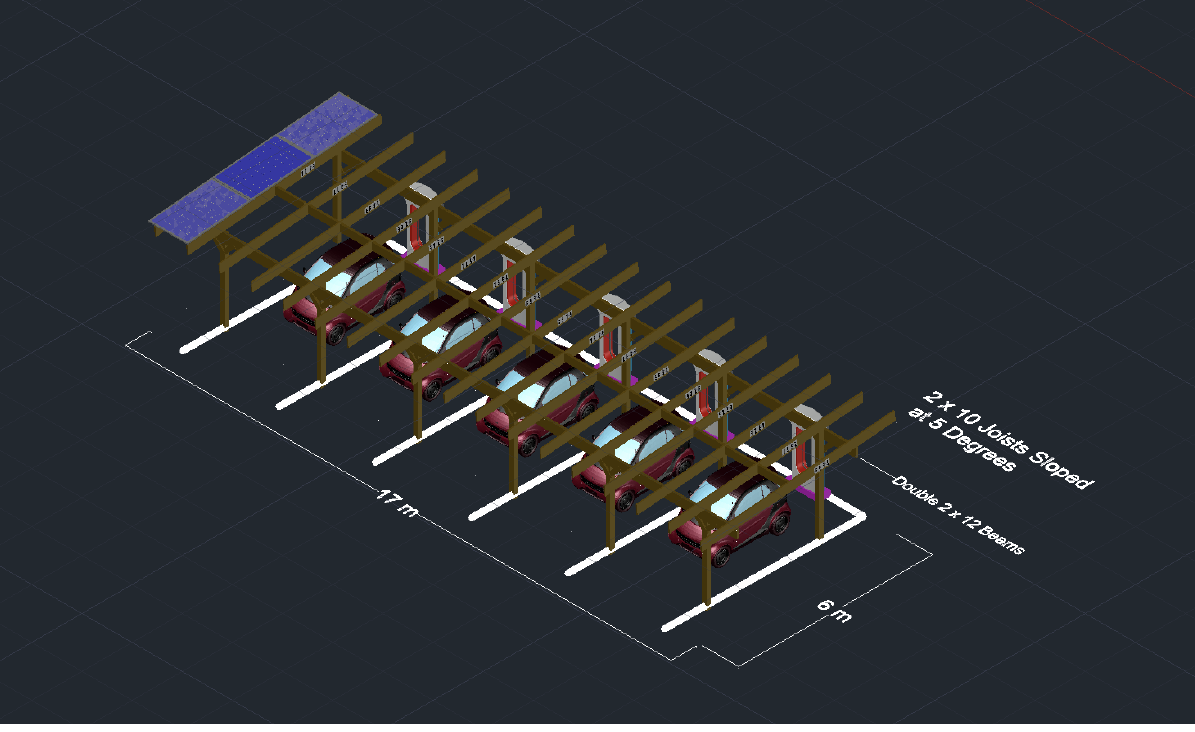
Figure 6. Finished Single-Span System. 3.2. Double Spanning System 3.2.1. Double Spanning System Bill of Materials The BOM of the two-span system is shown in Table 5 in Canadian dollars sourced from Copp’s Build-All, London, and Metal Supermarkets, London.